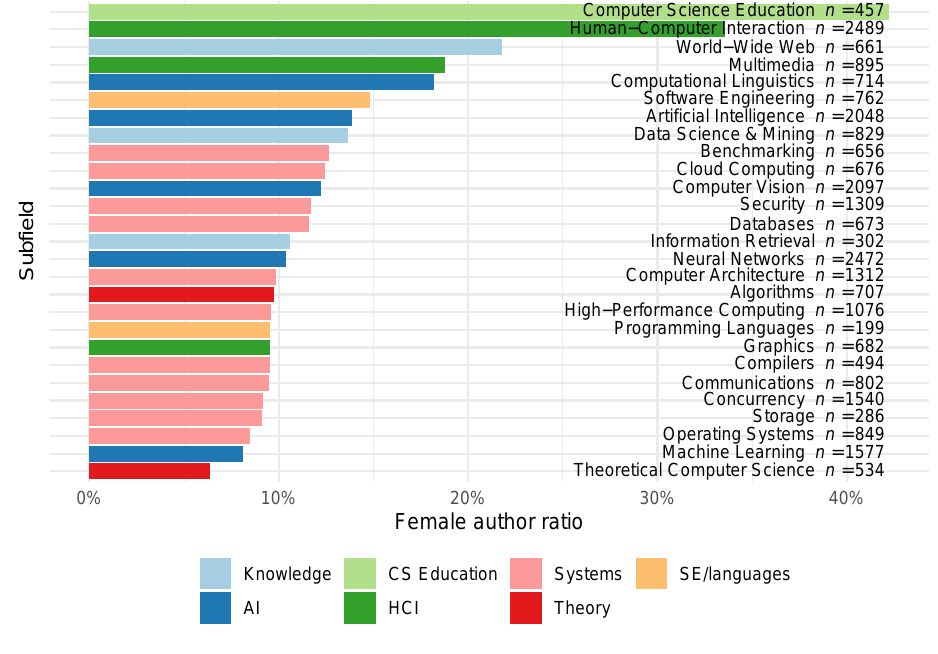
Figure 1. Female author ratio by